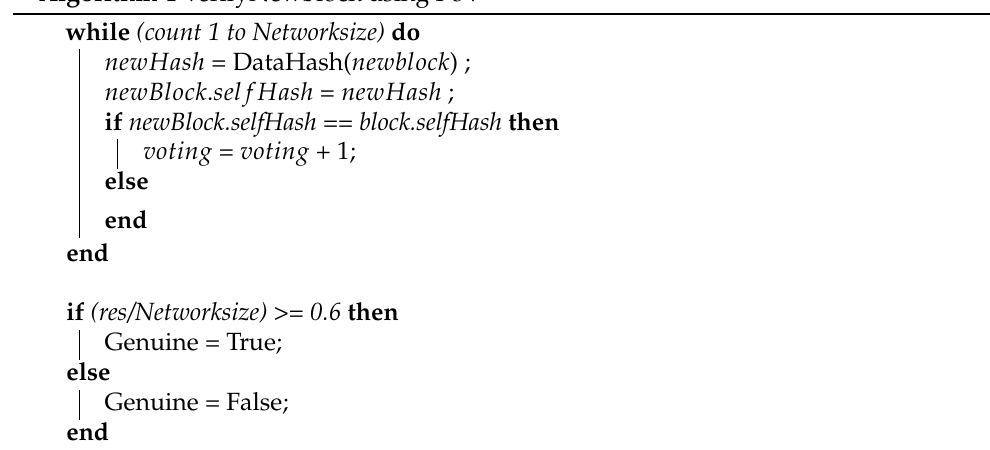
Algorithm 4 VerifyNewblock using